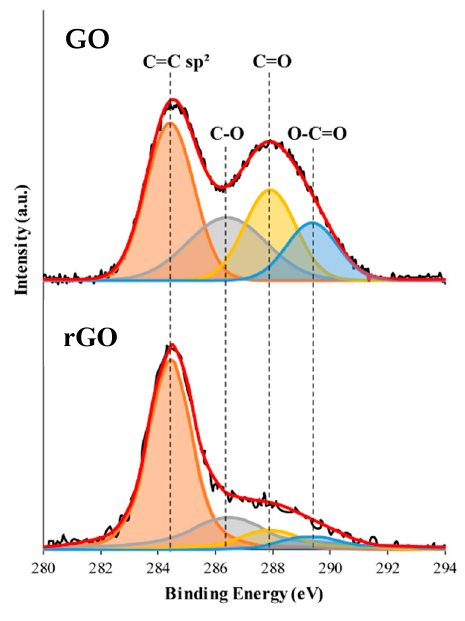
Figure 4. XPS spectra of GO and rGO.